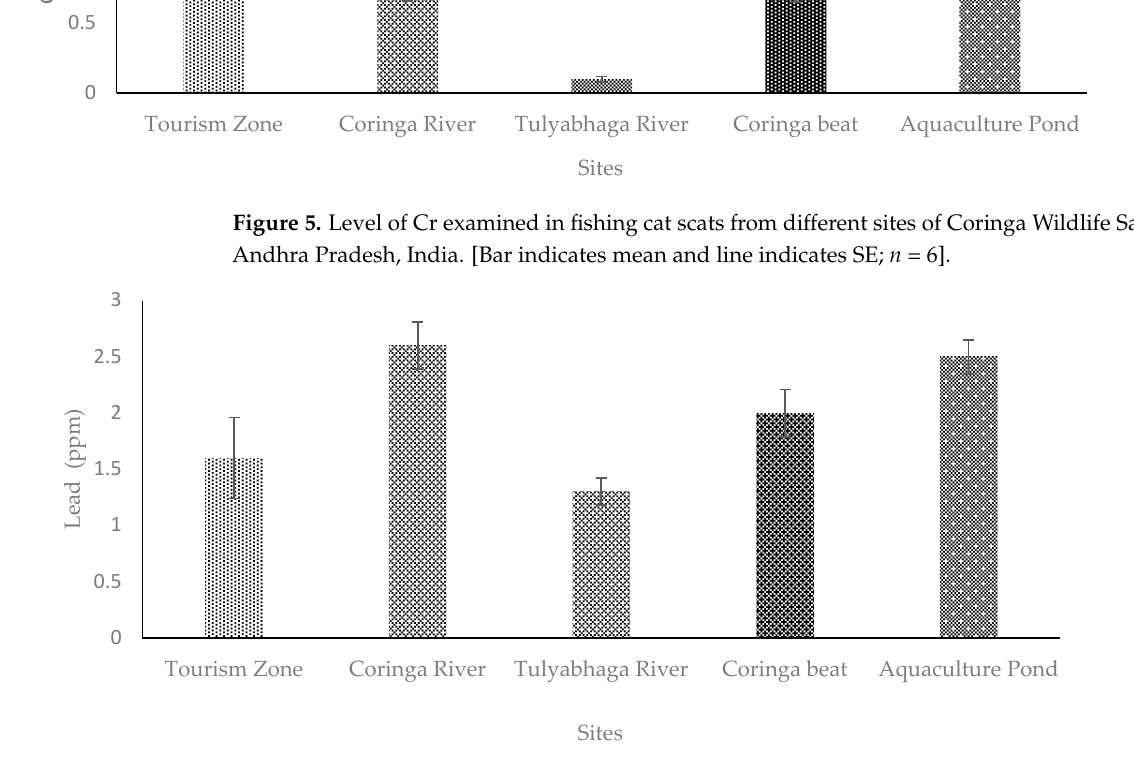
Figure 6. Level of Pb examined in fishing cat scats from different sites of Coringa Wildlife Sanctuary, Andhra Pradesh, India. [Bar indicates mean and line indicates SE; n = 6].